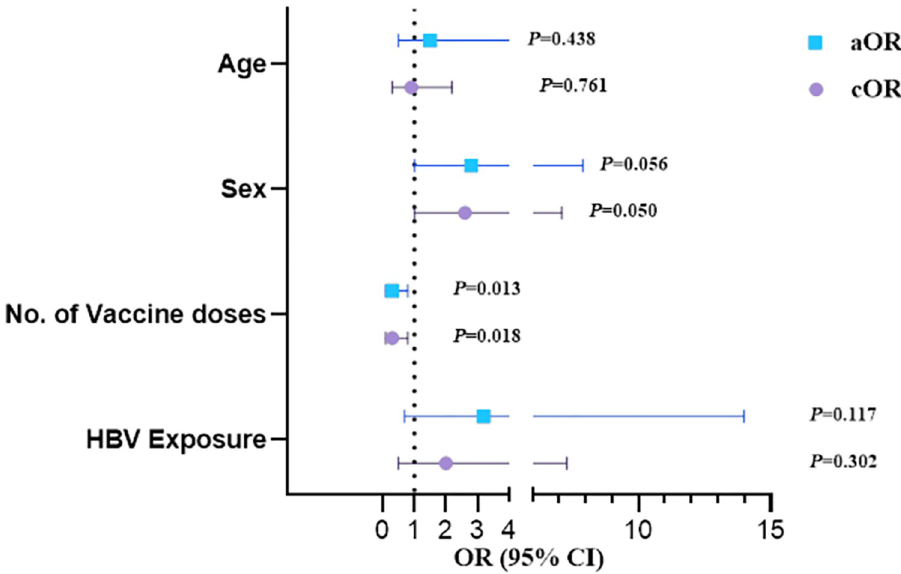
Fig 1. Odds ratio for covariates that impact anti-HBs production among HCW. ORs and 95% CI with significant associations indicated at P < 0.05 Abbreviations: OR, odds ratio; cOR, crude odds ratio; aOR, adjusted odds ratio; CI, confidence